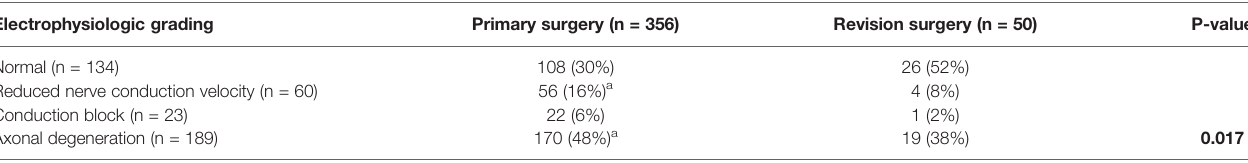
TABLE 2 | Relation between electrophysiologic grading and type of surgery in 406 surgically treated cases with ulnar nerve entrapment. Electrophysiologic grading